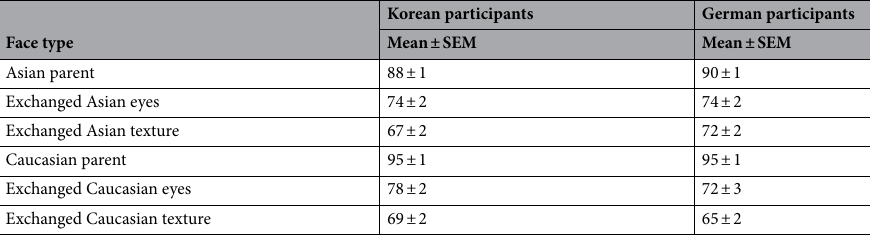
Table 2. Mean ethnicity choices for the race of the exchanged feature (eyes or texture) given in percent and calculated for each participant group. The categorization values for the parent faces are given for comparison. SEM: standard error of the mean.